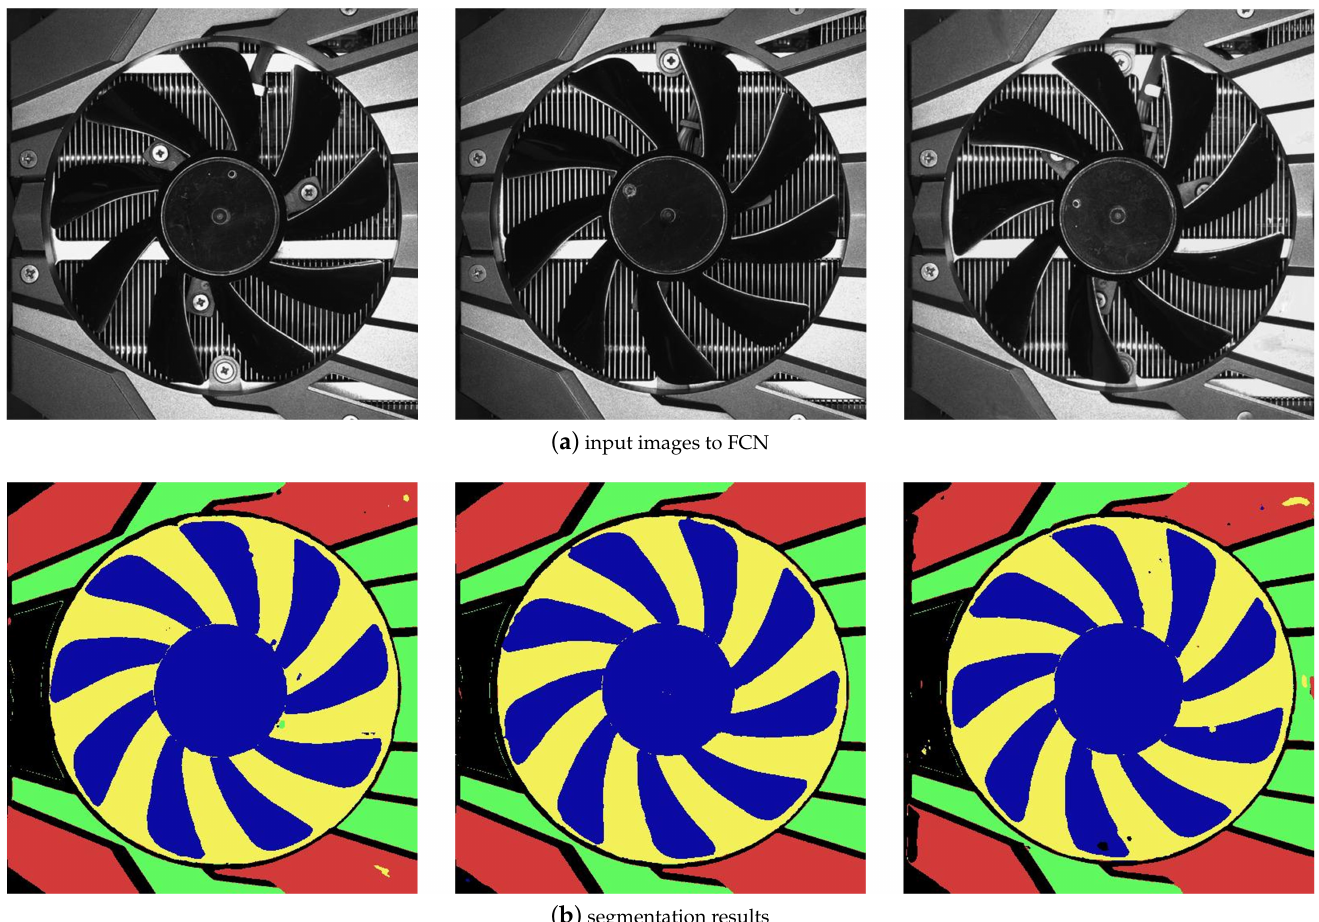
Figure 14. Examples of segmentation results produced by FCN for backplate images. ( a ) The input images to the FCN; ( b ) the segmentation results, where the surfaces are separated into five regions labeled by blue, yellow, red, green, and black colors,